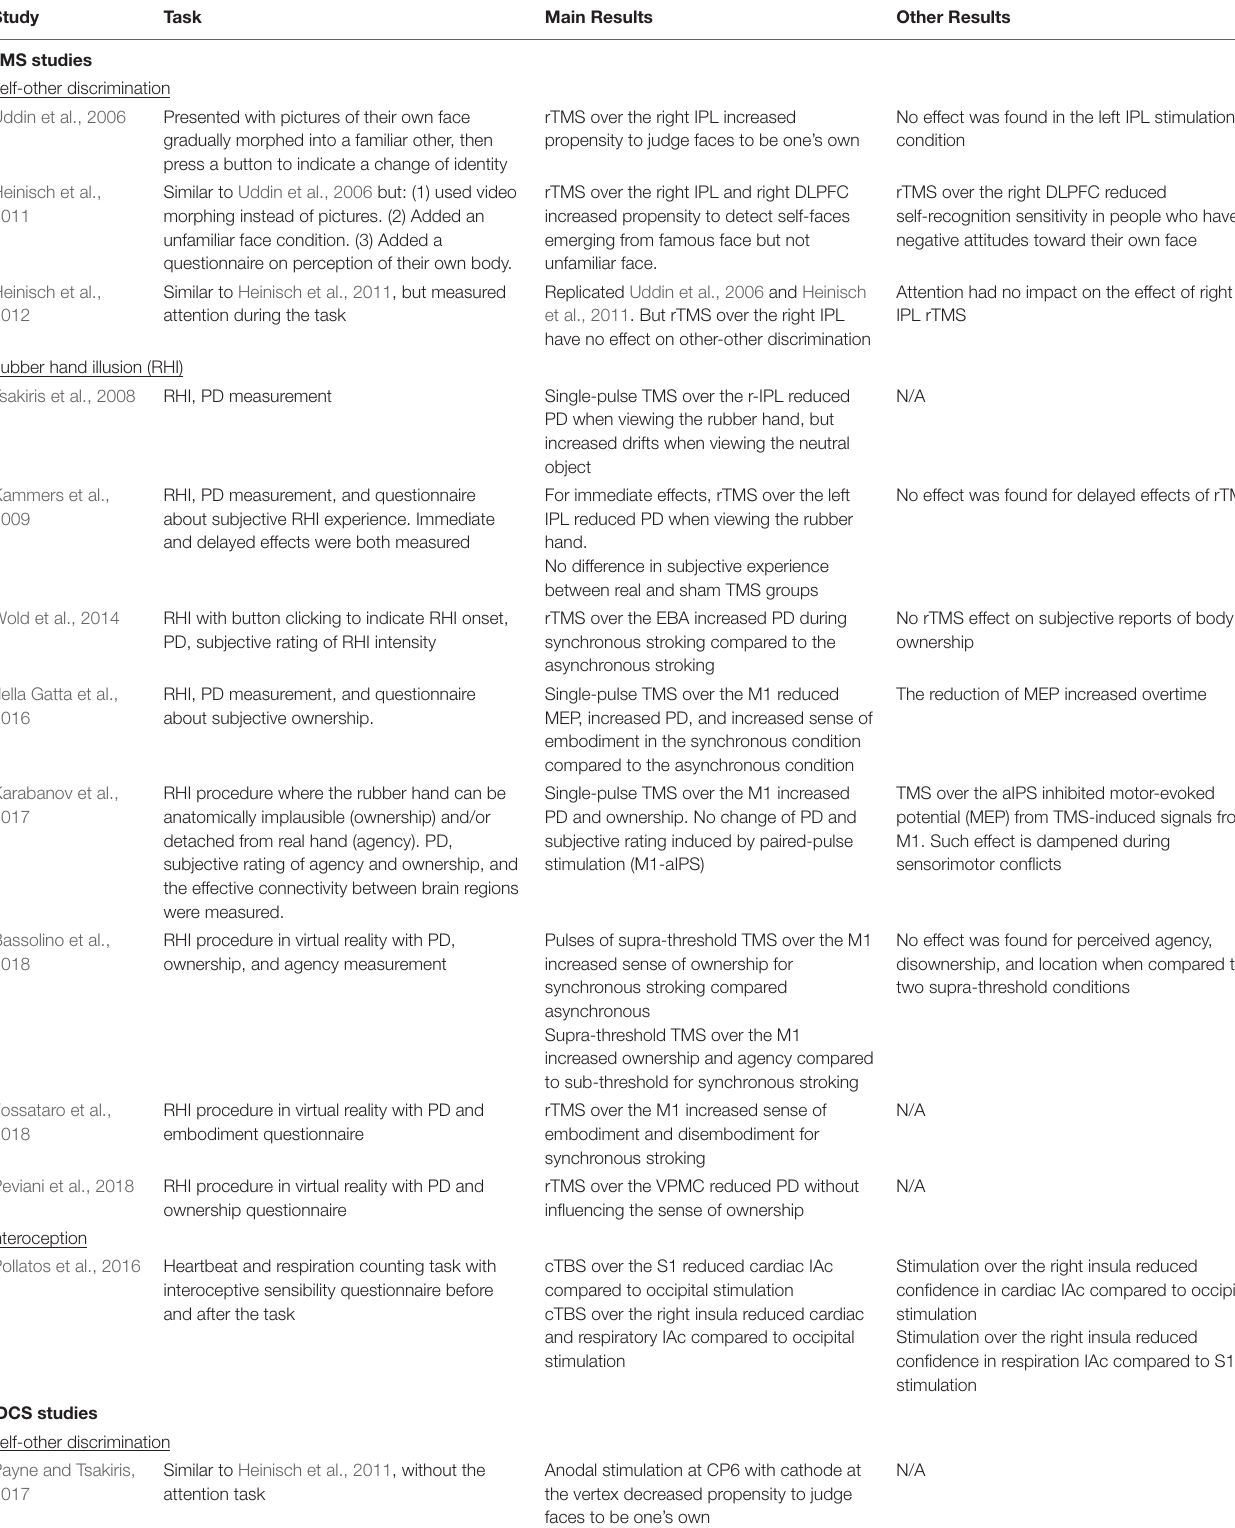
TABLE 4 | Summary of results of the included NV-SRP